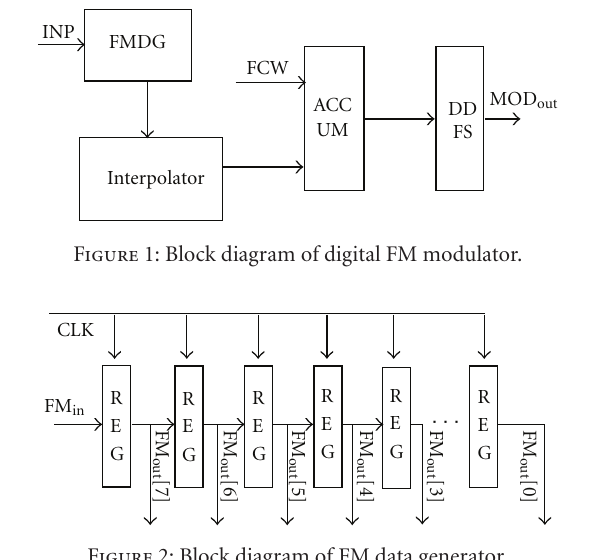
Figure 2: Block diagram of FM data